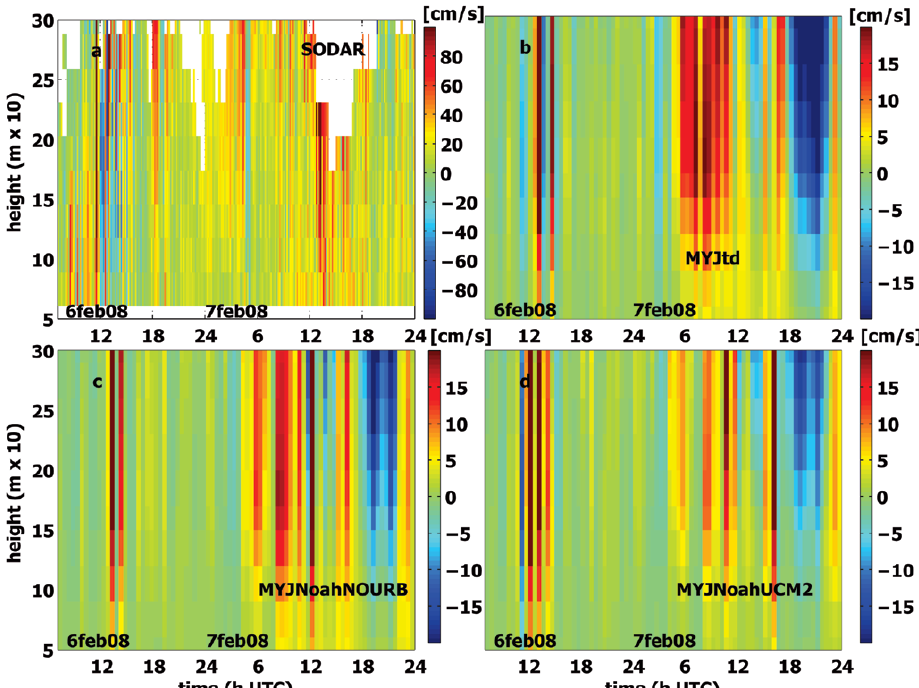
Fig. 11. Time series of the vertical wind speed vertical profile on 6–7 February 2008 for (a) sodar measurements, (b) MYJtd, (c) MYJNoah- NOURB, (d) MYJNoahUCM2. Time is on the x axis and height on the ordinate axis.